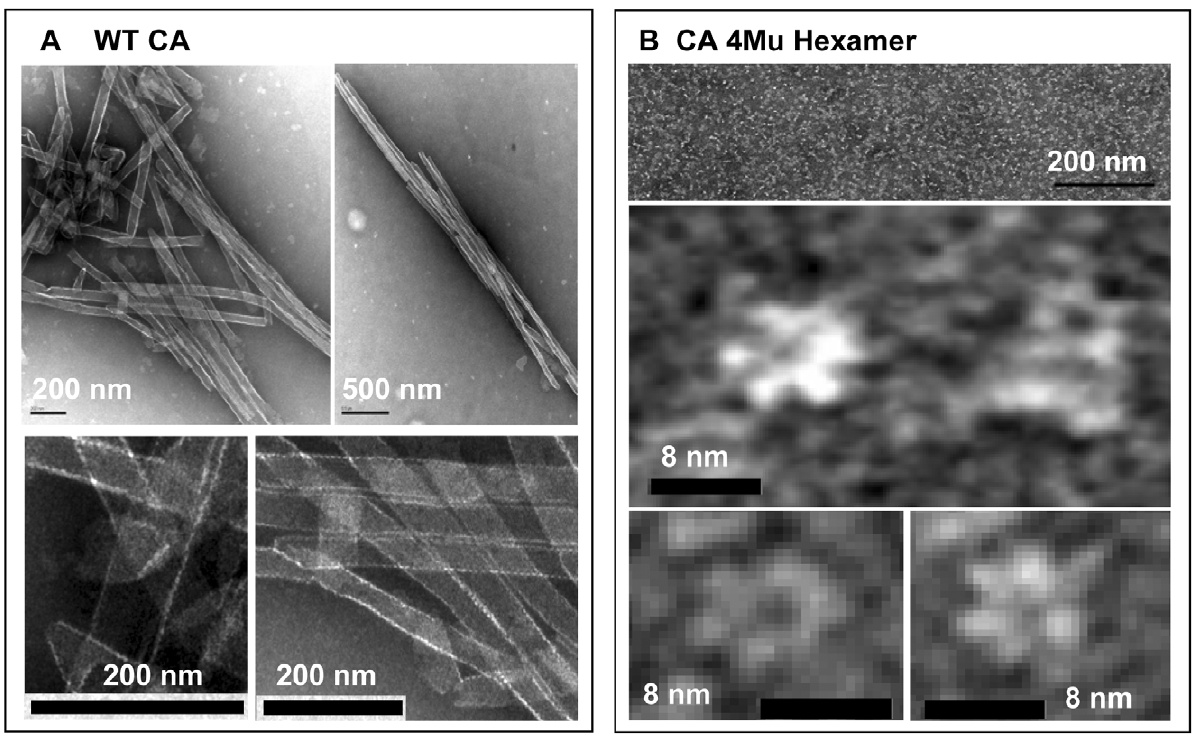
Figure 4. Transmission electron microscopy analysis of structures present in the solution of (A) polymerized WT CA and (B) assembled CA 4Mu Hexamer. Objects were deposited onto the grid and visualized by the negative staining. Black bar on micrographs represents scale in nm. ( A ) Tube-like and cone-like structures can be observed in solution of WT CA polymerized at 40 m M concentration in buffer containing 50 mM sodium phosphate (pH 7.5), 2 M NaCl, 0.005% Antifoam 204. ( B ) Hexameric assemblies are clearly visible in a solution containing 19.5 m M of disulfide cross-linked CA 4Mu (expressed as CA monomers concentration) in 20 mM Tris (pH 8.0), 10% glycerol buffer.